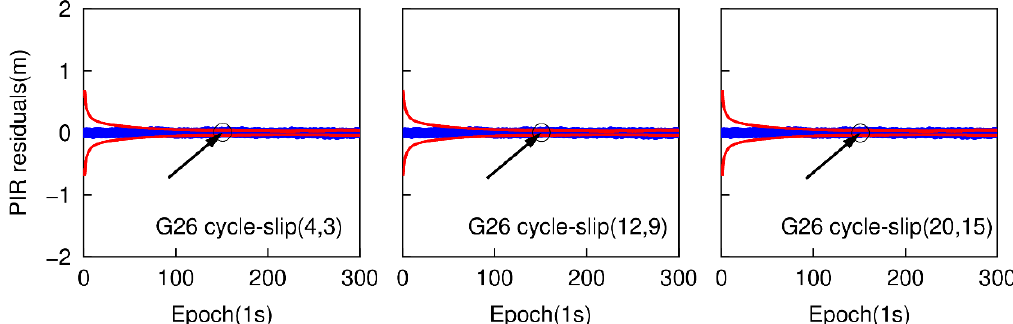
Figure 11. Specific small cycle-slip combination detection results with PIR combination for G26.